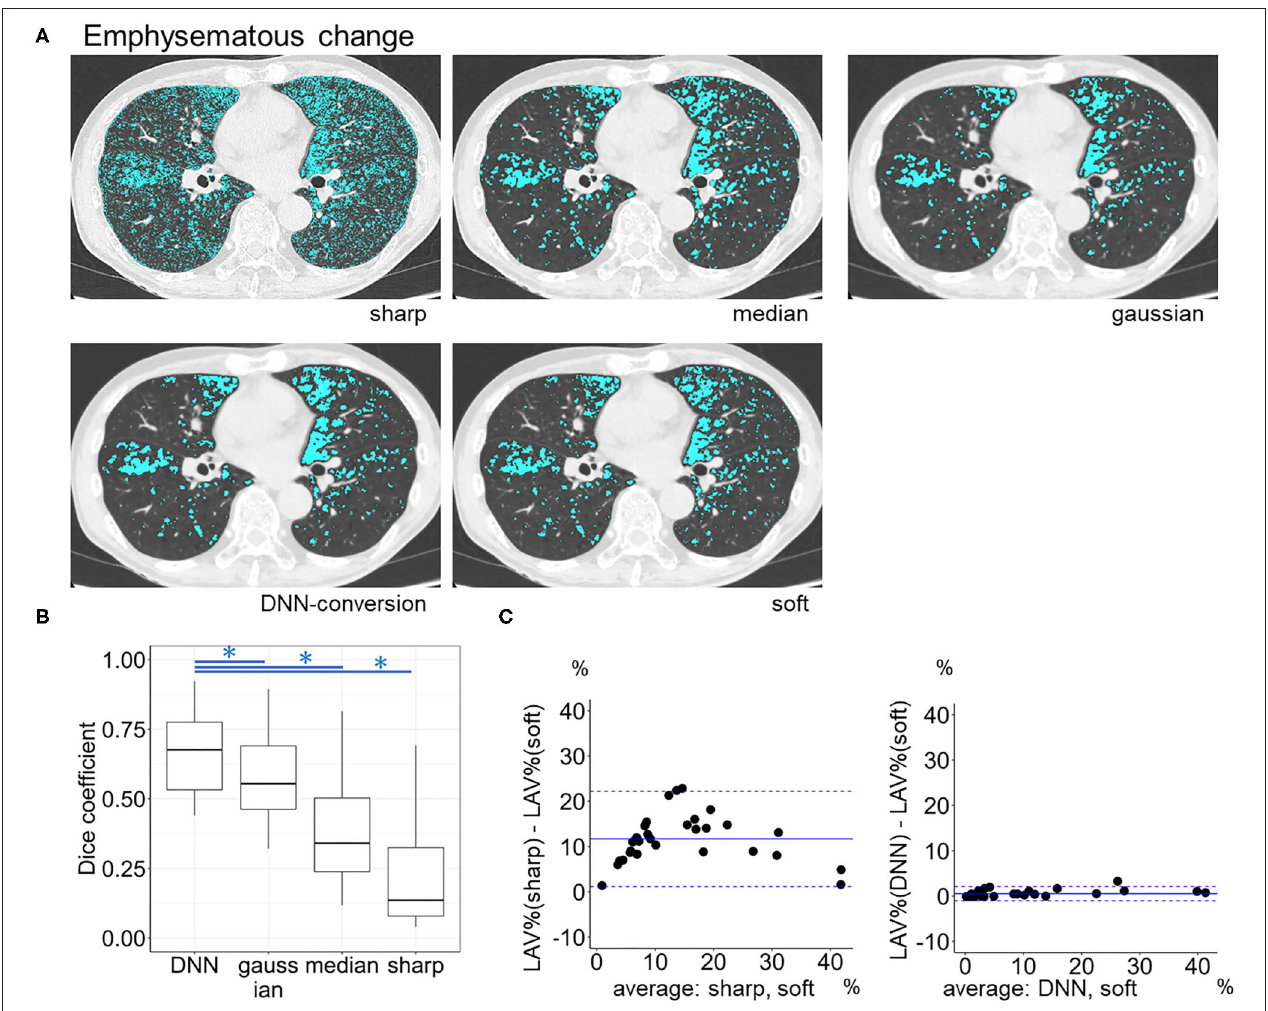
FIGURE 6 | Emphysema quantification on deep learning-based kernel-converted images. (A) Emphysematous change (blue) on the original sharp-kernel, median-filtered, Gaussian-filtered (sharp to soft), kernel conversion, and original soft-kernel images. (B) The Dice coefficients quantified the similarity between low attenuation voxels on given images and the ground-truth soft-kernel images in the validation dataset ( n = 30). *indicates p < 0.001 based on paired t -tests with Bonferroni correction. (C) Bland-Altman plots of the extent of emphysematous change, assessed as low attenuation volume % (LAV%), show that LAV% on converted and soft-kernel images were close to each other. Solid blue line indicates the mean difference (bias) between the two measurements. Upper and lower dashed lines indicate 95% limits of